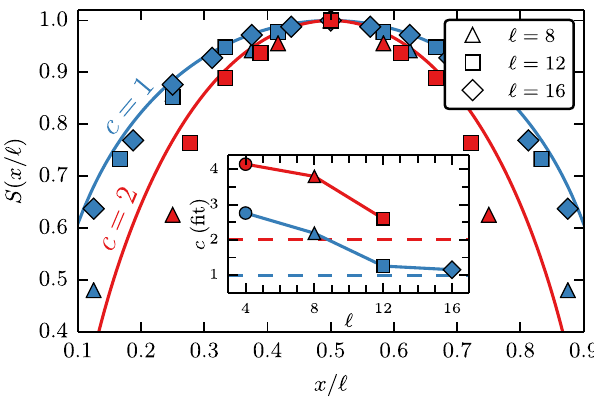
FIG. 6. Entanglement entropy of the 1 þ 1 d ground state of the − log ρ , with ρ the reduced entanglement Hamiltonian H E ¼ density matrix for a bipartite cut on an infinite cylinder of circumference l . Blue points are for j Ψ , and red points are gTrivial i . Data are offset so that S ð 1 = 2 Þ ¼ 1 for j Ψ gSPT i